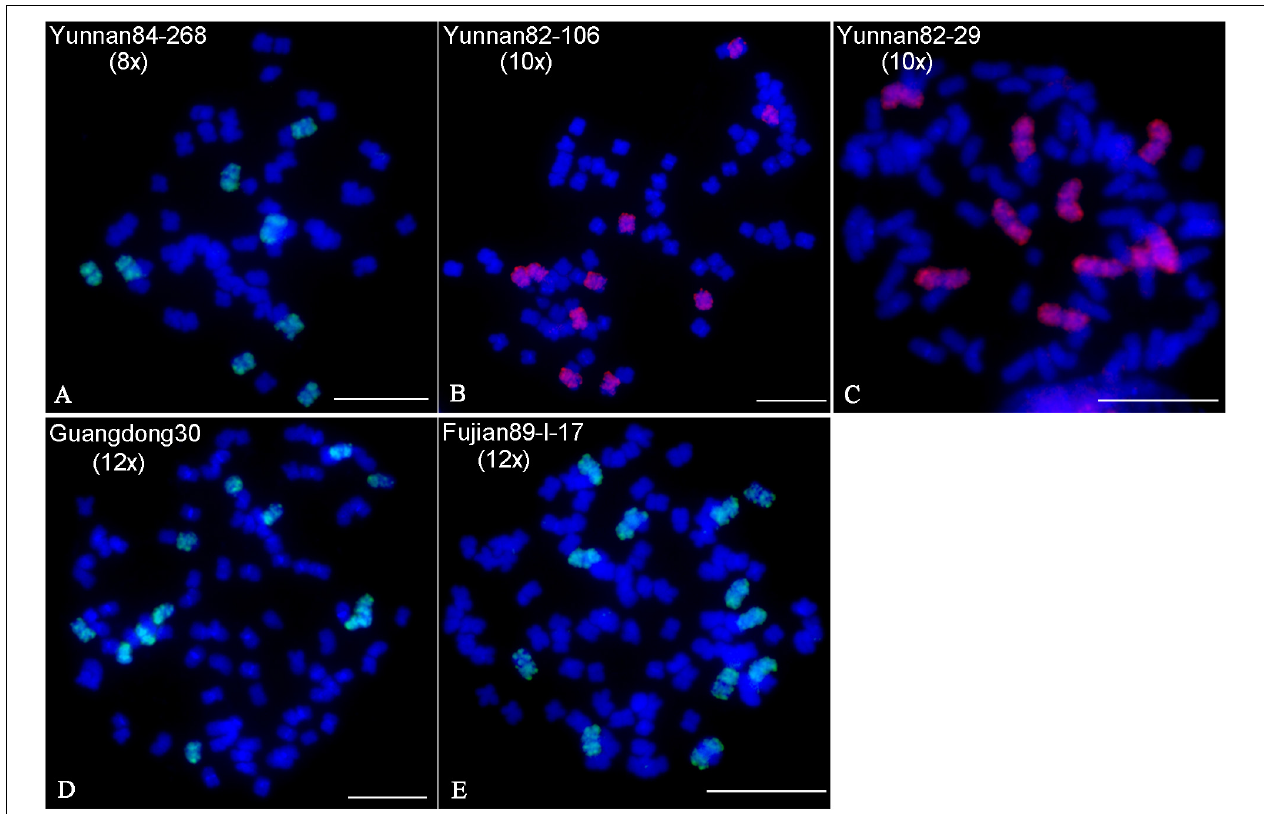
FIGURE 2 | Identification of ploidies in S. spontaneum clones by chromosome painting. The CP2 probe was hybridized to the mitotic metaphase chromosomes of five S. spontaneum clones, Yunnan84-268 (A) , Yunnan82-106 (B) , Yunnan82-29 (C) , Guangdong30 (D) , and Fujian89-I-17 (E) . Scale bars, 10 µ